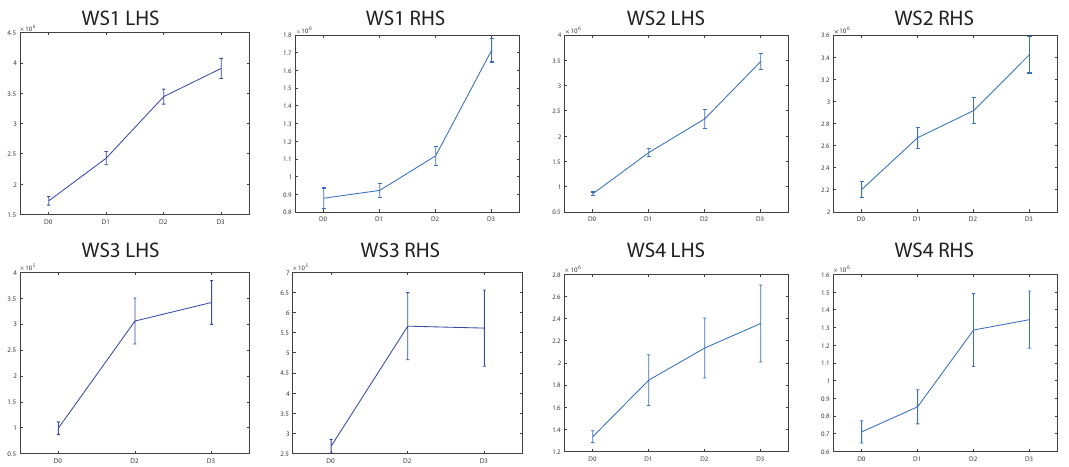
Figure 8. Evolution of energies (mean and standard deviation; (V 2 /s)) versus crack levels D0, D1, D2, and D3 for packet number 2 in longitudinal acceleration.